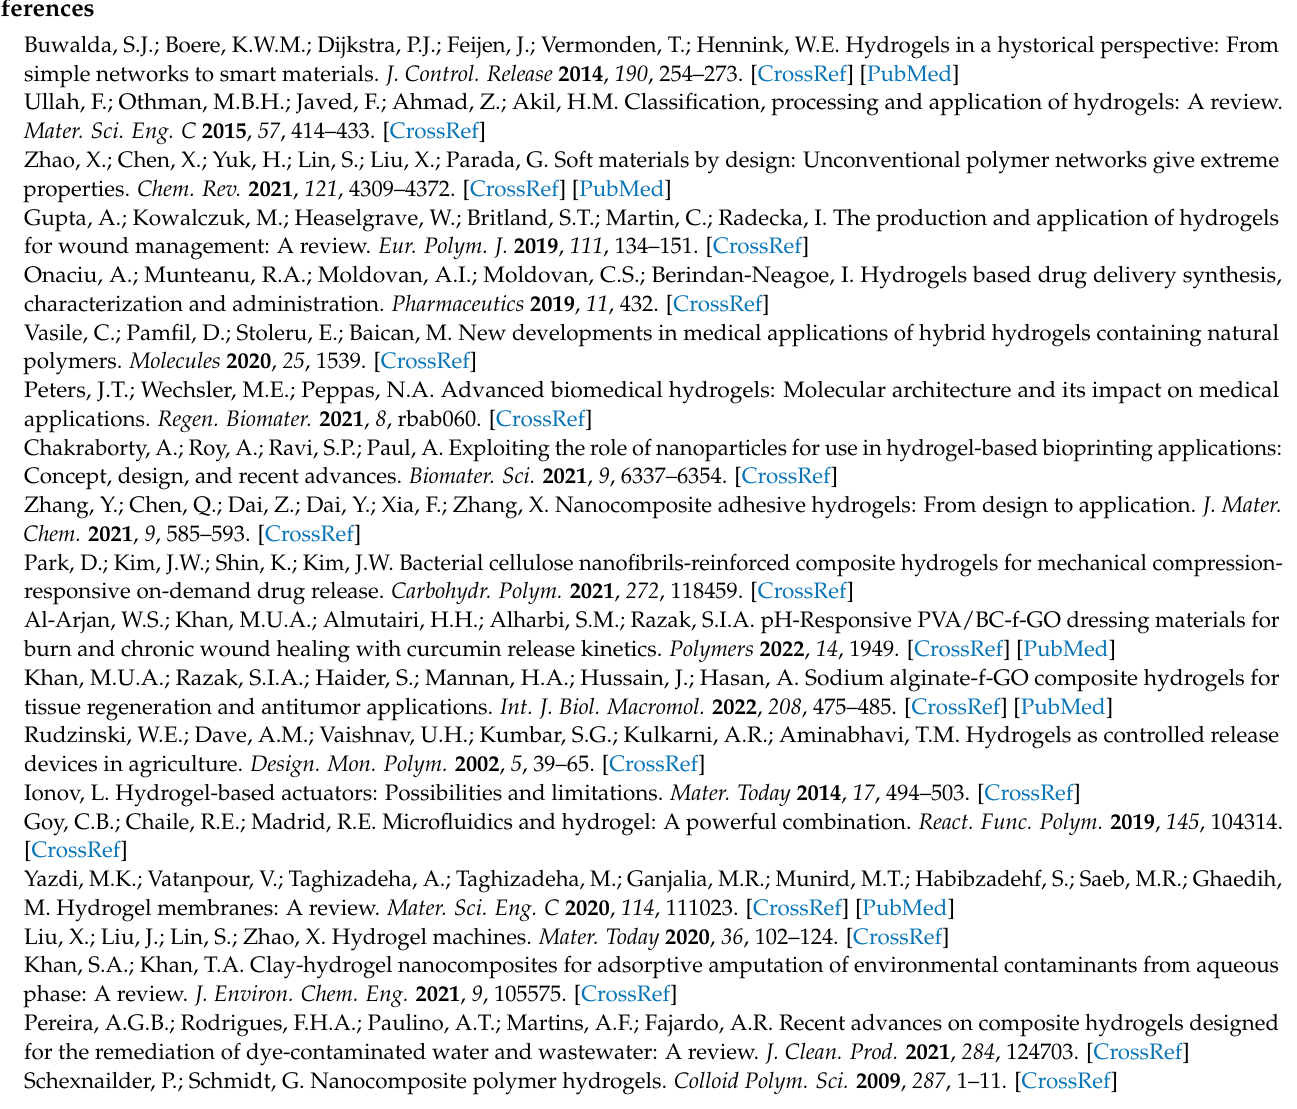
monomers used. Figure S2. EDX analyses of the synthesized hydrogels. (a) HMBA 4 ; (b) HXLG 10 ; (c) HMBA 4 -XLG 10 . Figure S3. The descending order of the hydrogel samples from the point of view of (a) ultimate compressive stress and (b) elastic modulus. Figure S4. Comparison among the ultimate compressive strains and the loss factors of the synthesized hydrogels. Table S1. Comparison between the storage (G (cid:48) ) and compressive shear (G) moduli of the synthesized hydrogels. Table S2. The E (elastic modulus)/G (shear modulus) ratios for the synthesized